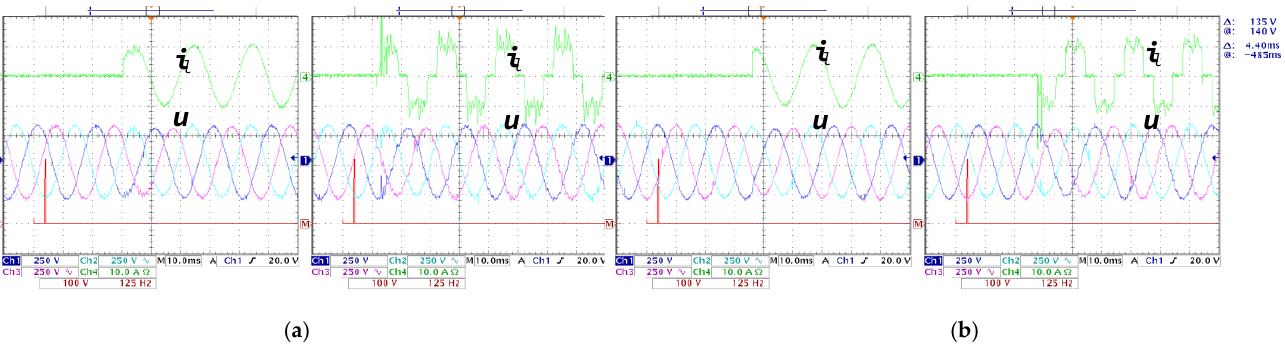
Figure 11. Dynamic waveforms of the conventional linear quadratic regulation (LQR) with differ- ent LC filter parameters: ( a ) 2 mH, 30 μF (nominal); ( b ) 2 mH, 60 μF.